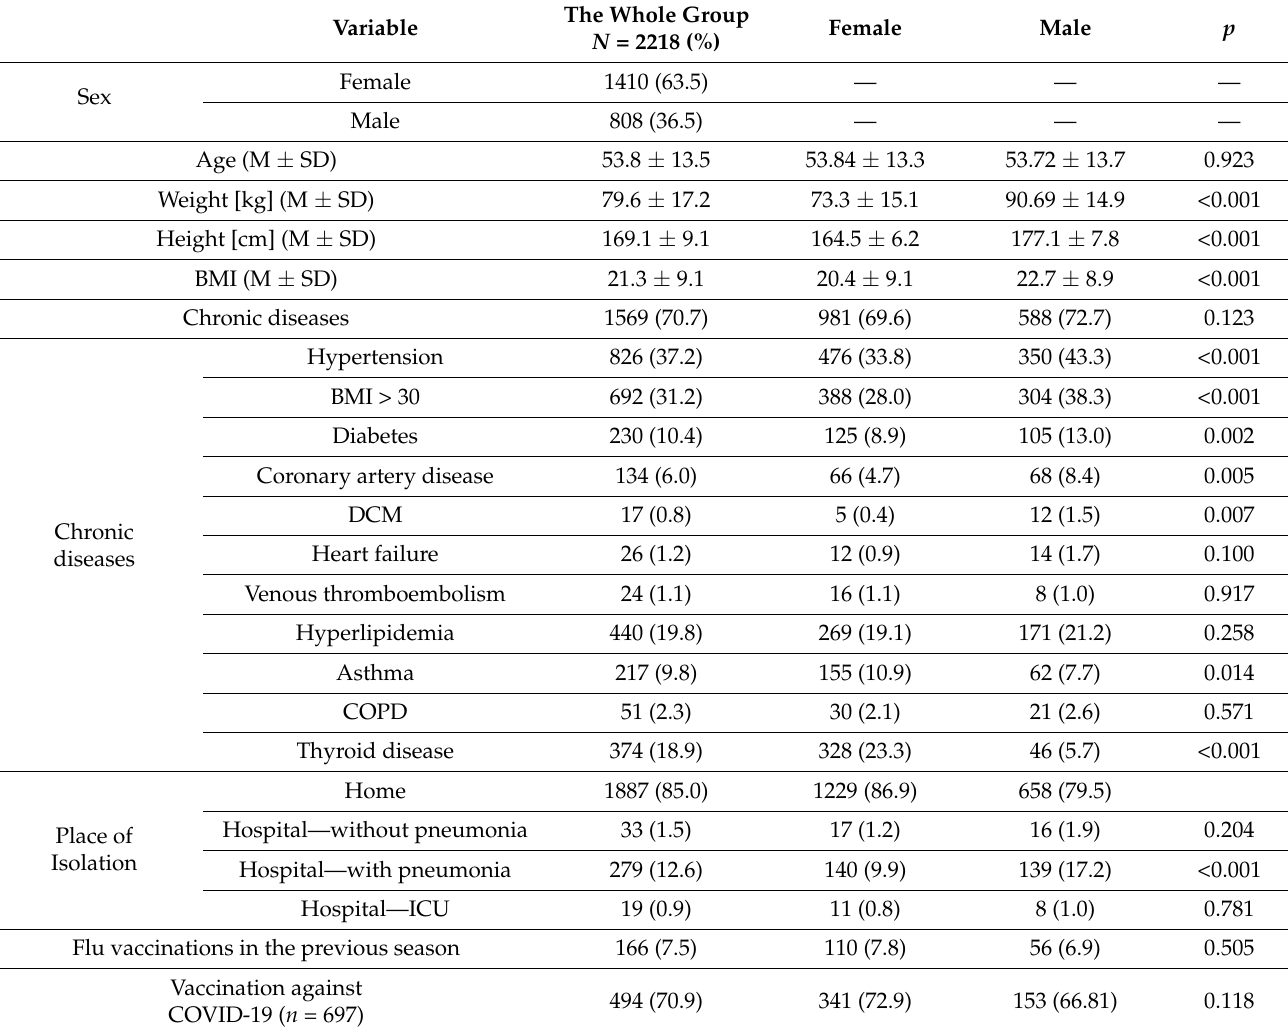
Table 1. Characteristics of the study group.